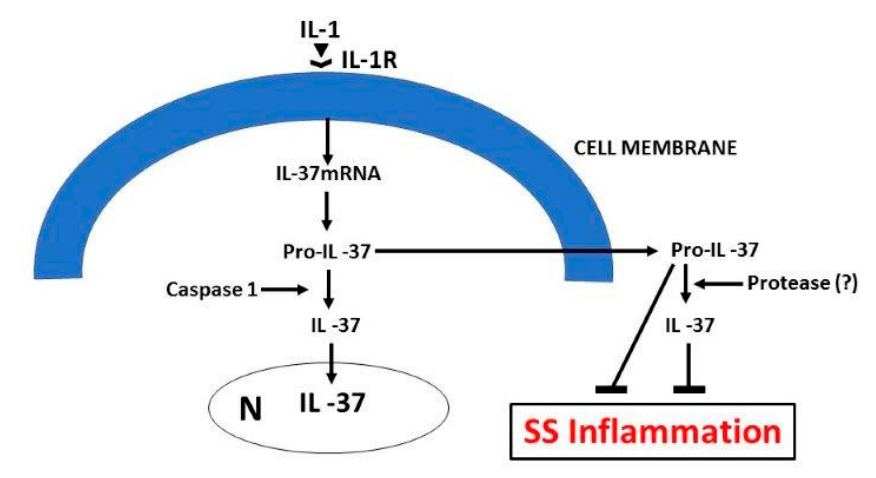
Figure 4. In this figure, we show the mechanism of IL-37 exerting immuno-inhibitory function in Sjogren’s syndrome inflammation. IL: interleukin; mRNA: messenger ribonucleic